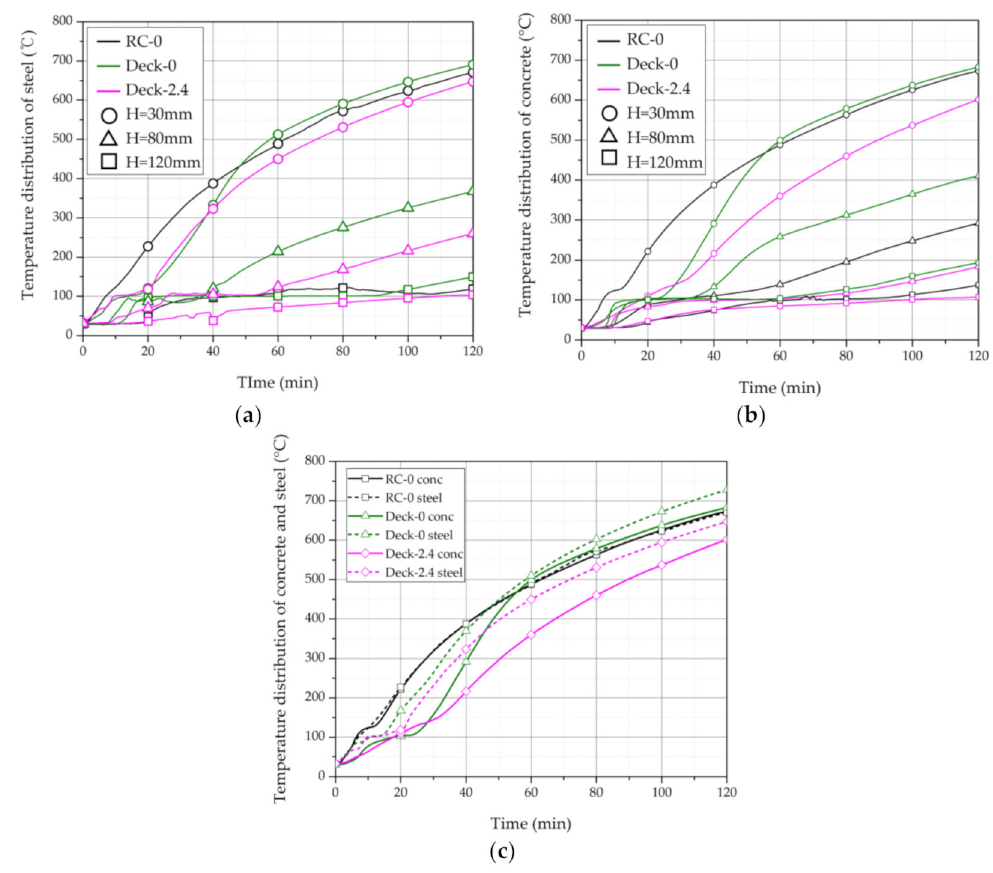
Figure 7. Internal temperature distribution. ( a ) Rebar and deck plates. ( b ) Concrete. ( c ) Concrete and steel temperatures at the 30-mm position. Table 8. Internal temperature of slab by